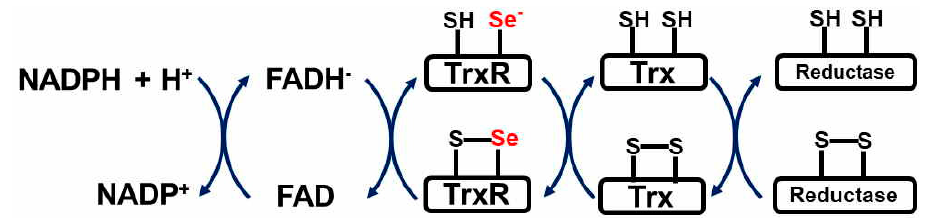
Figure 2. Catalytic redox cycle of the thioredoxin (Trx) / thioredoxin reductase (TrxR) / nicotinamide adenine dinucleotide phosphate (NADPH) system. FAD, flavin adenine dinucleotide.